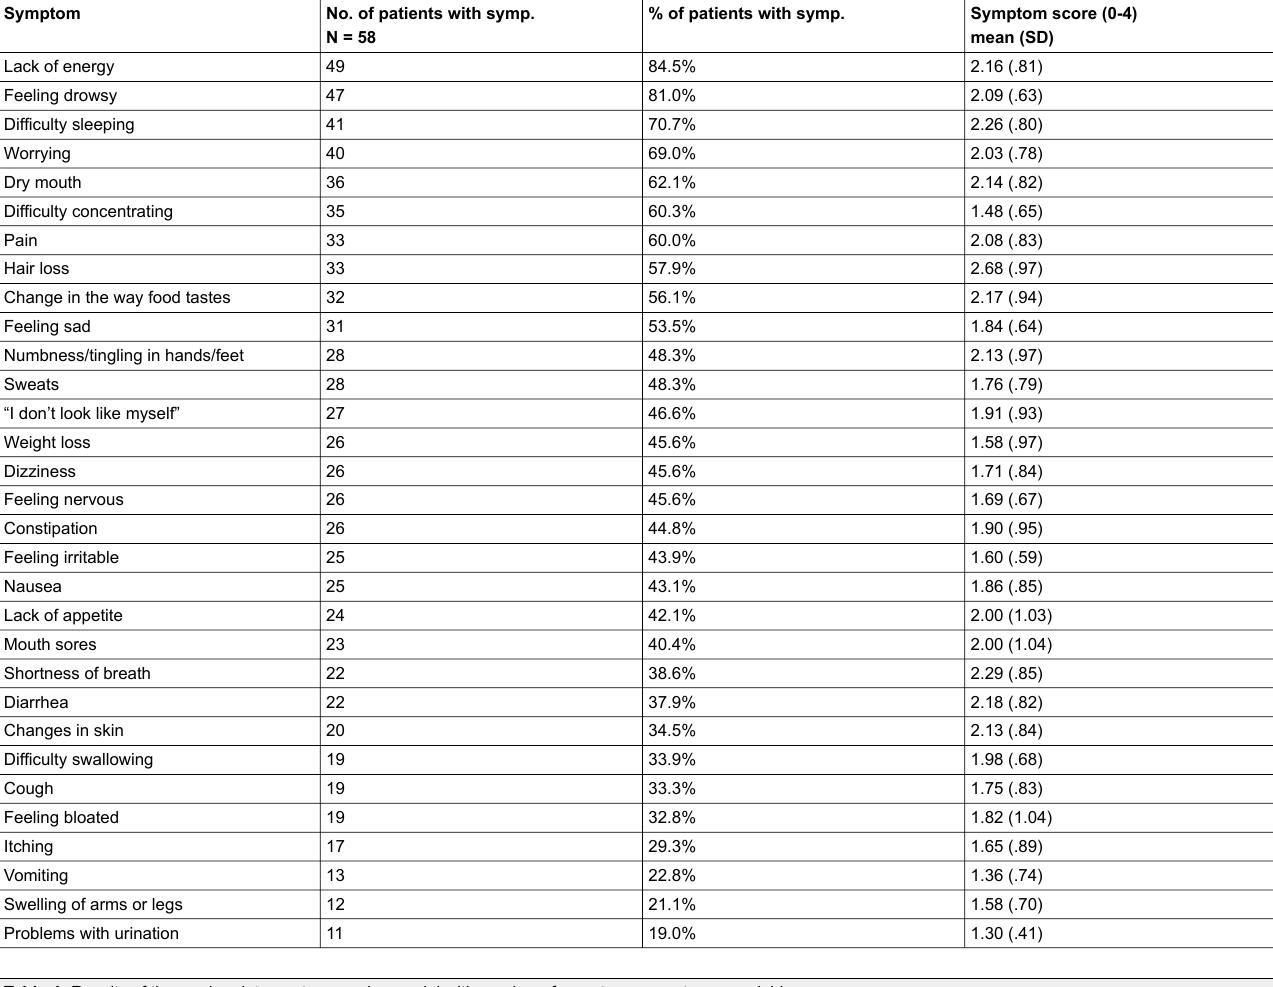
Table 3: Symptom prevalence in descending order at T2, with number and percentages of patients experiencing a symptom and symptom scores. Symptom